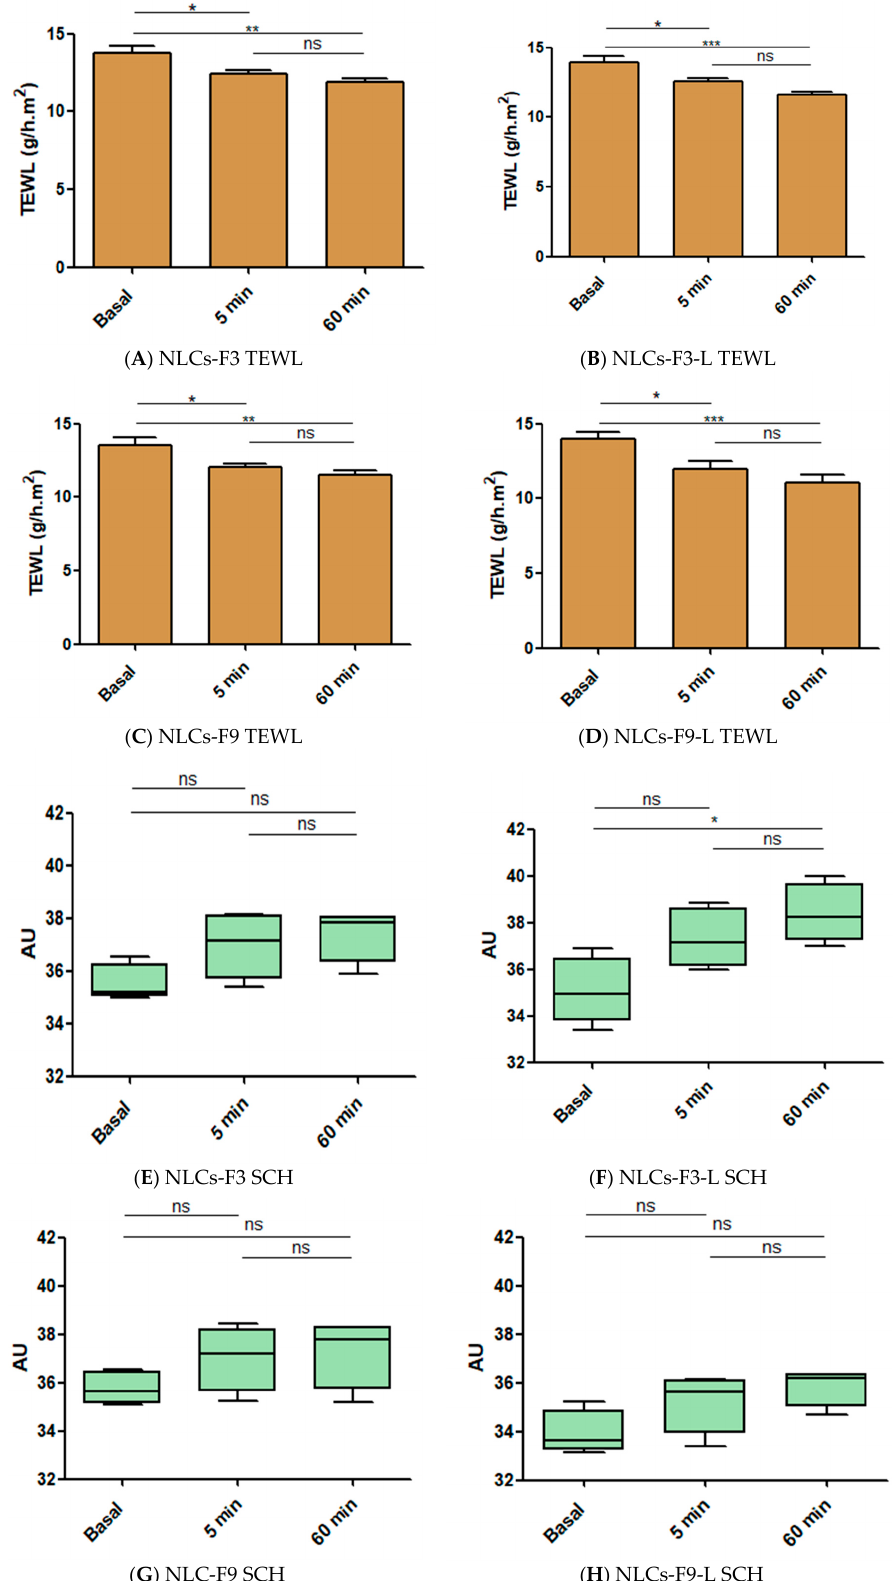
Figure 12. Biomechanical parameters evolution monitored before the application of the formulations and 1 h after application. TEWL is expressed as g/h × cm 2 and the SCH as arbitrary units (AU). Significant statistical differences: * p < 0.05, ** p < 0.01, *** p < 0.001, ns = non-significant.